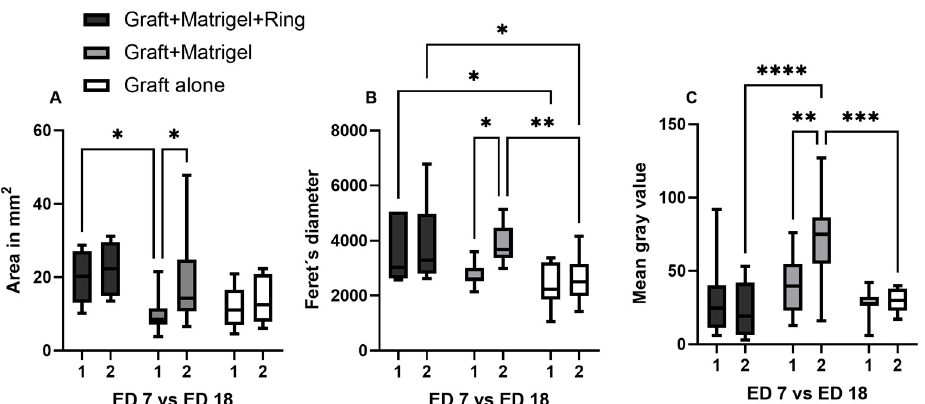
Figure 10. The cross-sectional area, Feret ´ s diameter, and mean gray value of the implanted uveal melanoma patient-derived tumors on ED7 and ED18 via Image J. ( A ) Comparison of the calculated cross-sectional area of the grafts between the three tested implantation techniques (group 1: graft + Matrigel + ring, group 2: graft + Matrigel, group 3: graft alone) and during growth period from ED7 to ED18 in each group, ( B ) calculation of the Feret´s diameter as a mass distribution parameter and comparison among the three tested groups and during the growth period from ED7 to ED18 in each group, ( C ) the mean gray value was measured as an indicator of tumor density among the three tested groups and during the growth period from ED7 to ED18 in each group. Statistical analysis was performed using a two-way ANOVA and Tukey’s multiple comparisons test. Significance levels are indicated with * p < 0.05, ** p < 0.01, *** p < 0.001, and **** p < 0.0001.